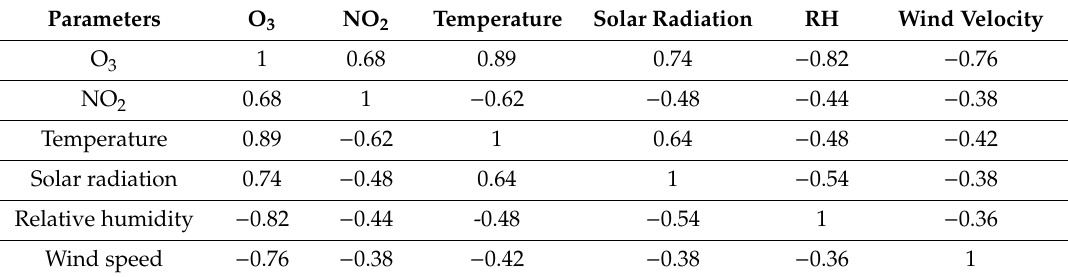
Table 1. Correlation between O 3 , NO 2 , and weather parameters from January 2013 to December 2018 (correlation is significant at 0.01